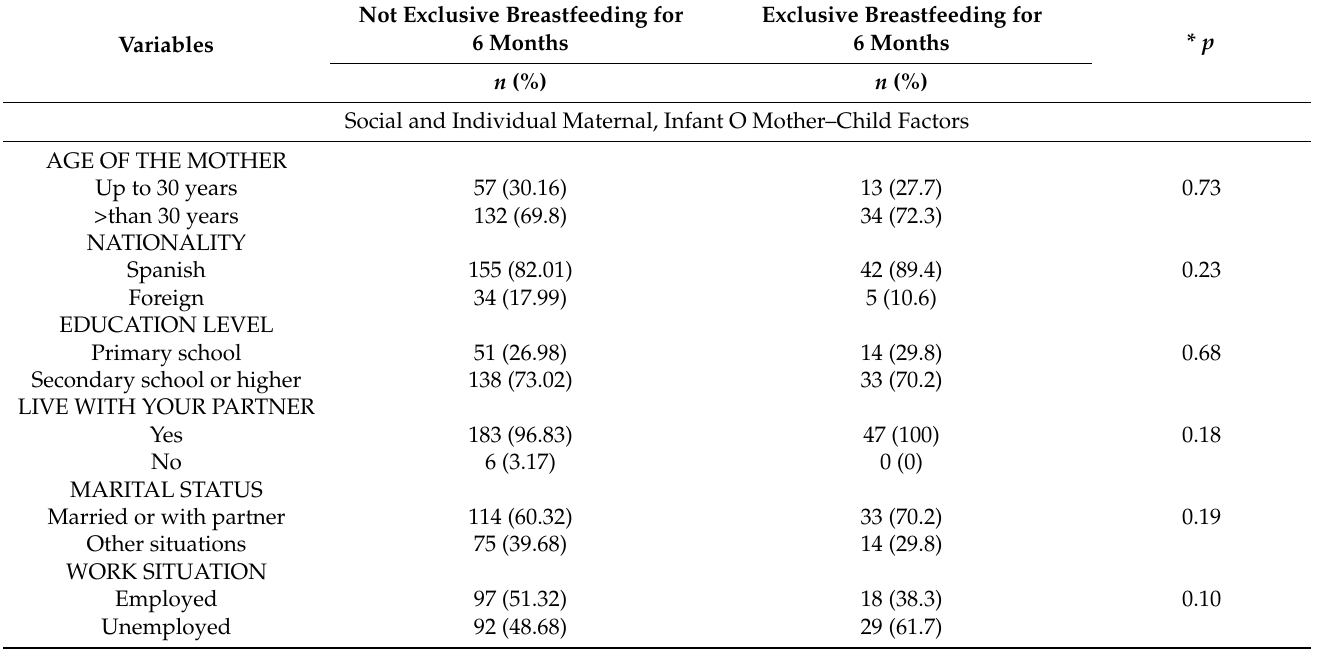
Table 1. Characteristics of the mother–child pairs participating in the study and their influence on the maintenance of exclusive breastfeeding for 6 months.